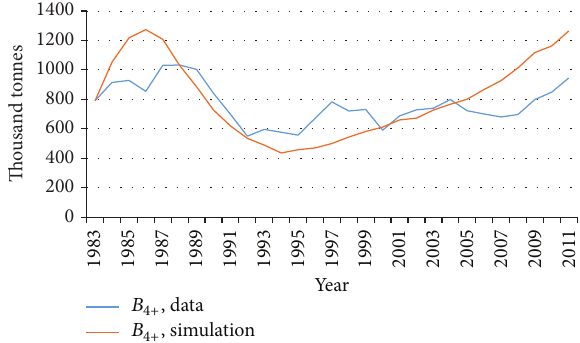
Figure 6: Comparison of output from model simulations and actual data for landings of cod.